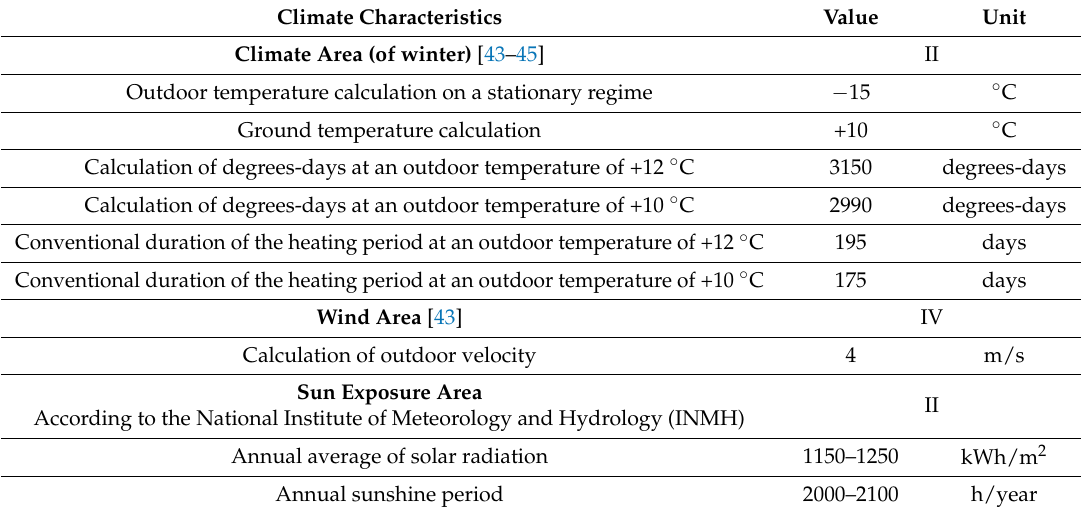
Table 1. Characteristics of the Oradea site.